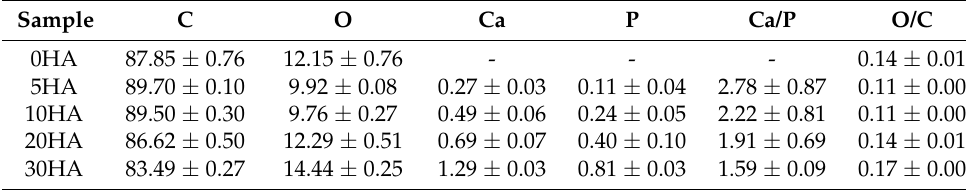
Table 3. Atomic Concentration %, Ca/P and O/C as determined by